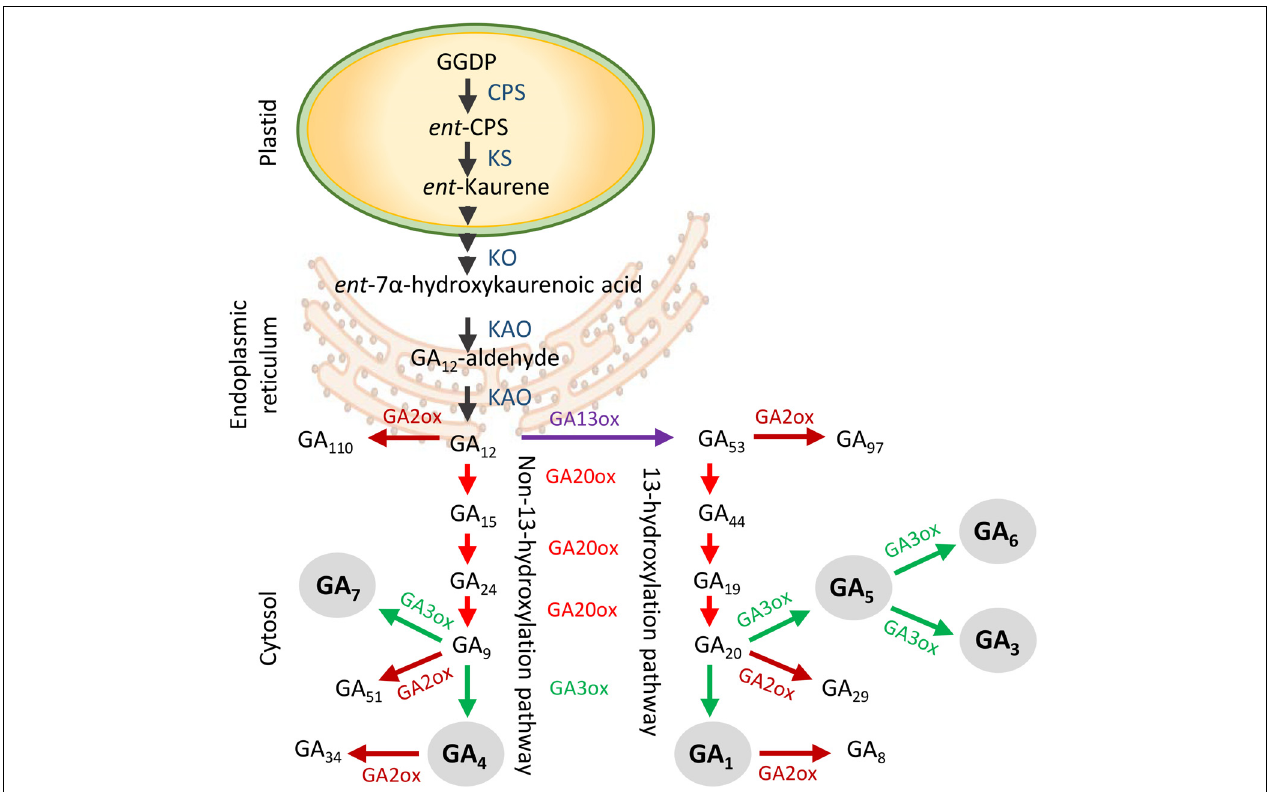
FIGURE 1 | Generalized scheme of gibberellin (GA) biosynthesis and deactivation in higher plants. GA biosynthesis starts in the plastids and is followed by the production of GA 12 in the endoplasmic reticulum. In the cytoplasm GA 12 is processed by GA20ox and GA3ox enzymes in two separate branches to produce bioactive GAs (gray circles). The non-13-hydroxylation yields GA 7 and GA 4 , whereas the 13-hydroxylation yields GA 5 , GA 6 , GA 3 , and GA 1 . The GA2ox enzymes deactivate precursors and bioactive GAs. Abbreviations: GGDP, geranylgeranyl diphosphate; CPS, ent- copalyl diphosphate synthase; KS, ent -kaurene synthase; KO, ent -kaurene oxidase; KAO, ent -kaurenoic acid oxidase.